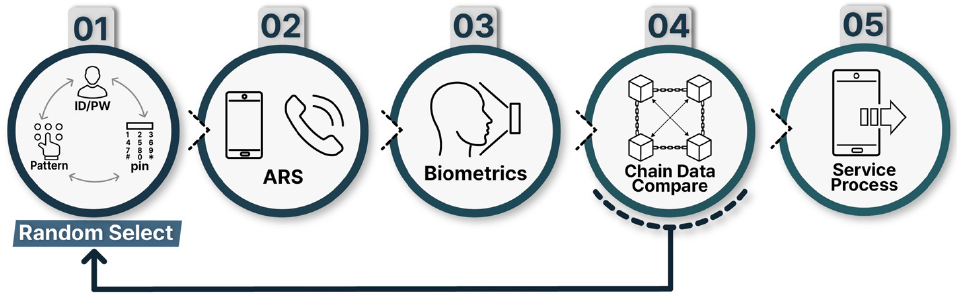
Figure 9. Multi-factor